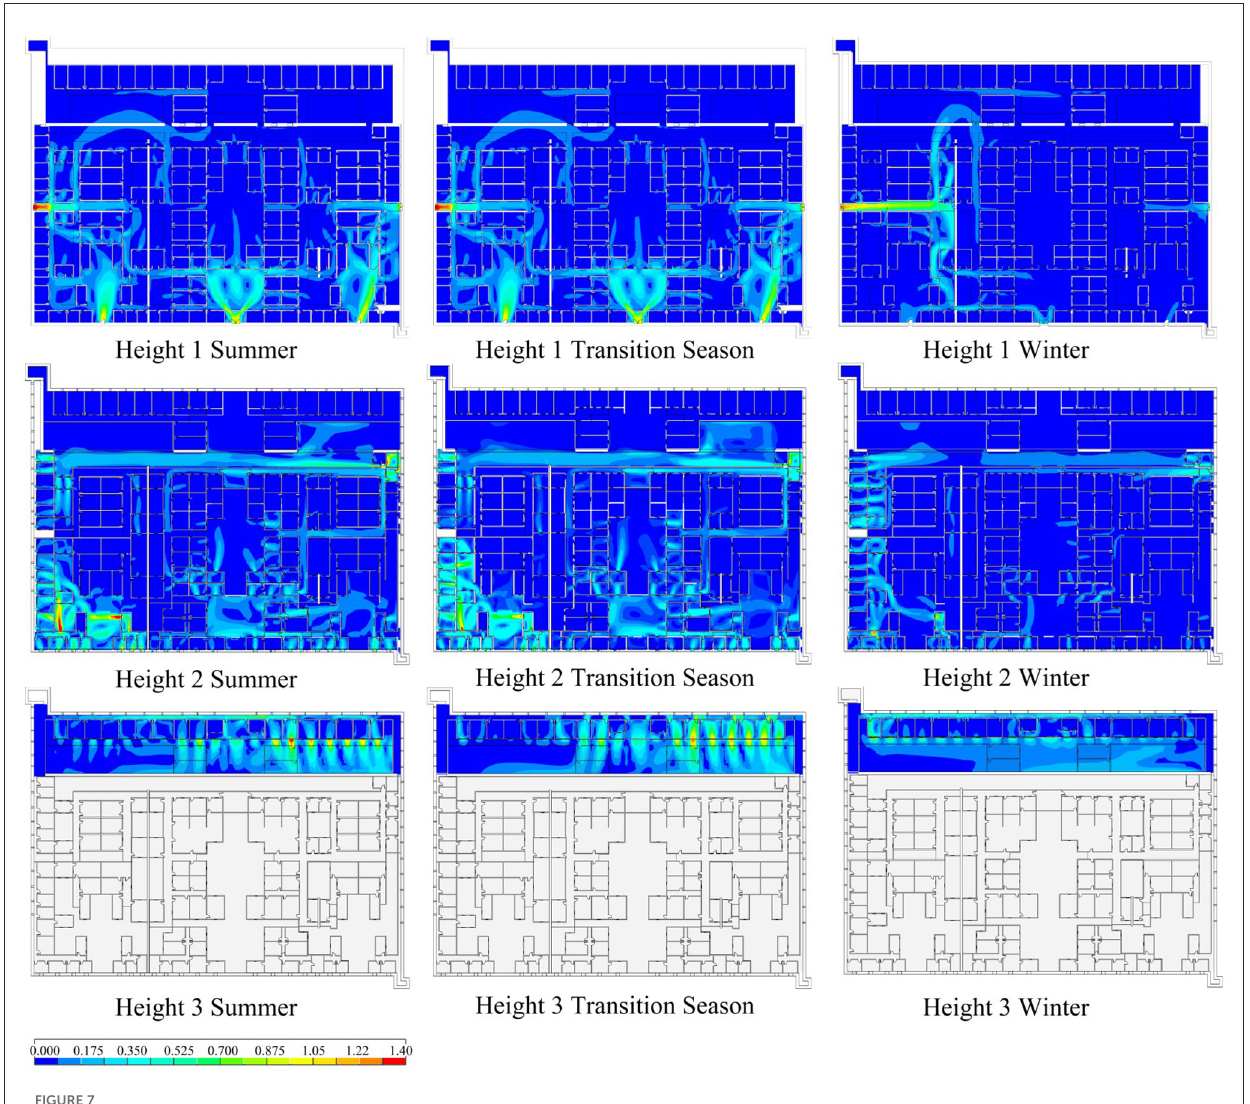
FIGURE7 Analysis of